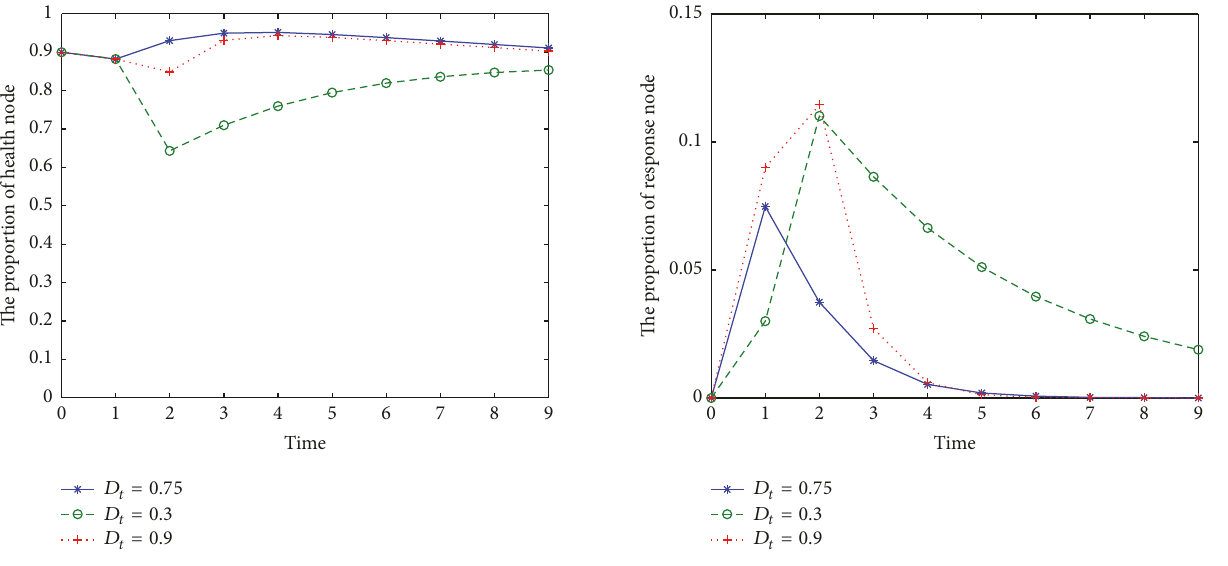
Figure 9: The proportion of responsive sensors.